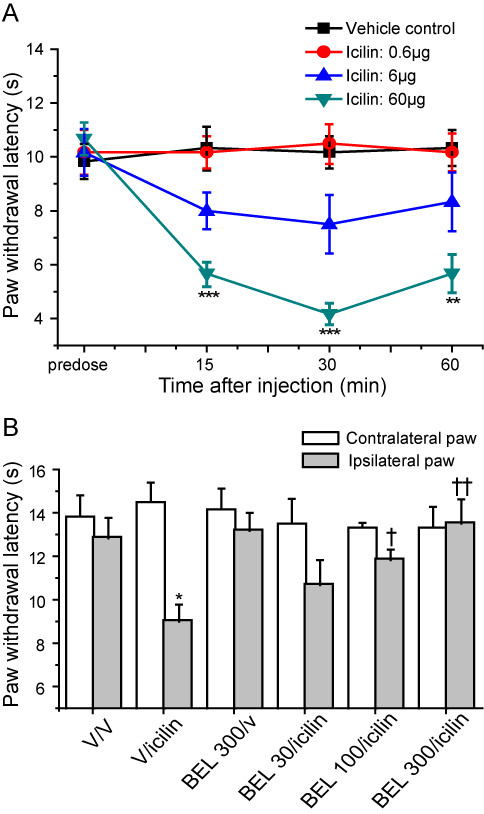
Icilin-induced cold hypersensitivity is inhibited by the iPLA2 inhibitor, BEL. A. Ipsilateral paw withdrawal latencies in lightly restrained rats at various times after intra-plantar administration of 0.6, 6 or 60 μg icilin or vehicle alone. B. Prior administration of 30-300 μg BEL dose dependently inhibited the cold hypersensitivity induced by 60 μg icilin. Data show mean ± SEM for 6 rats/group. * p < 0.05, ** p < 0.01, *** p < 0.001 vs vehicle. In B, † p < 0.05, †† p < 0.01 when compared with vehicle/icilin treated group.